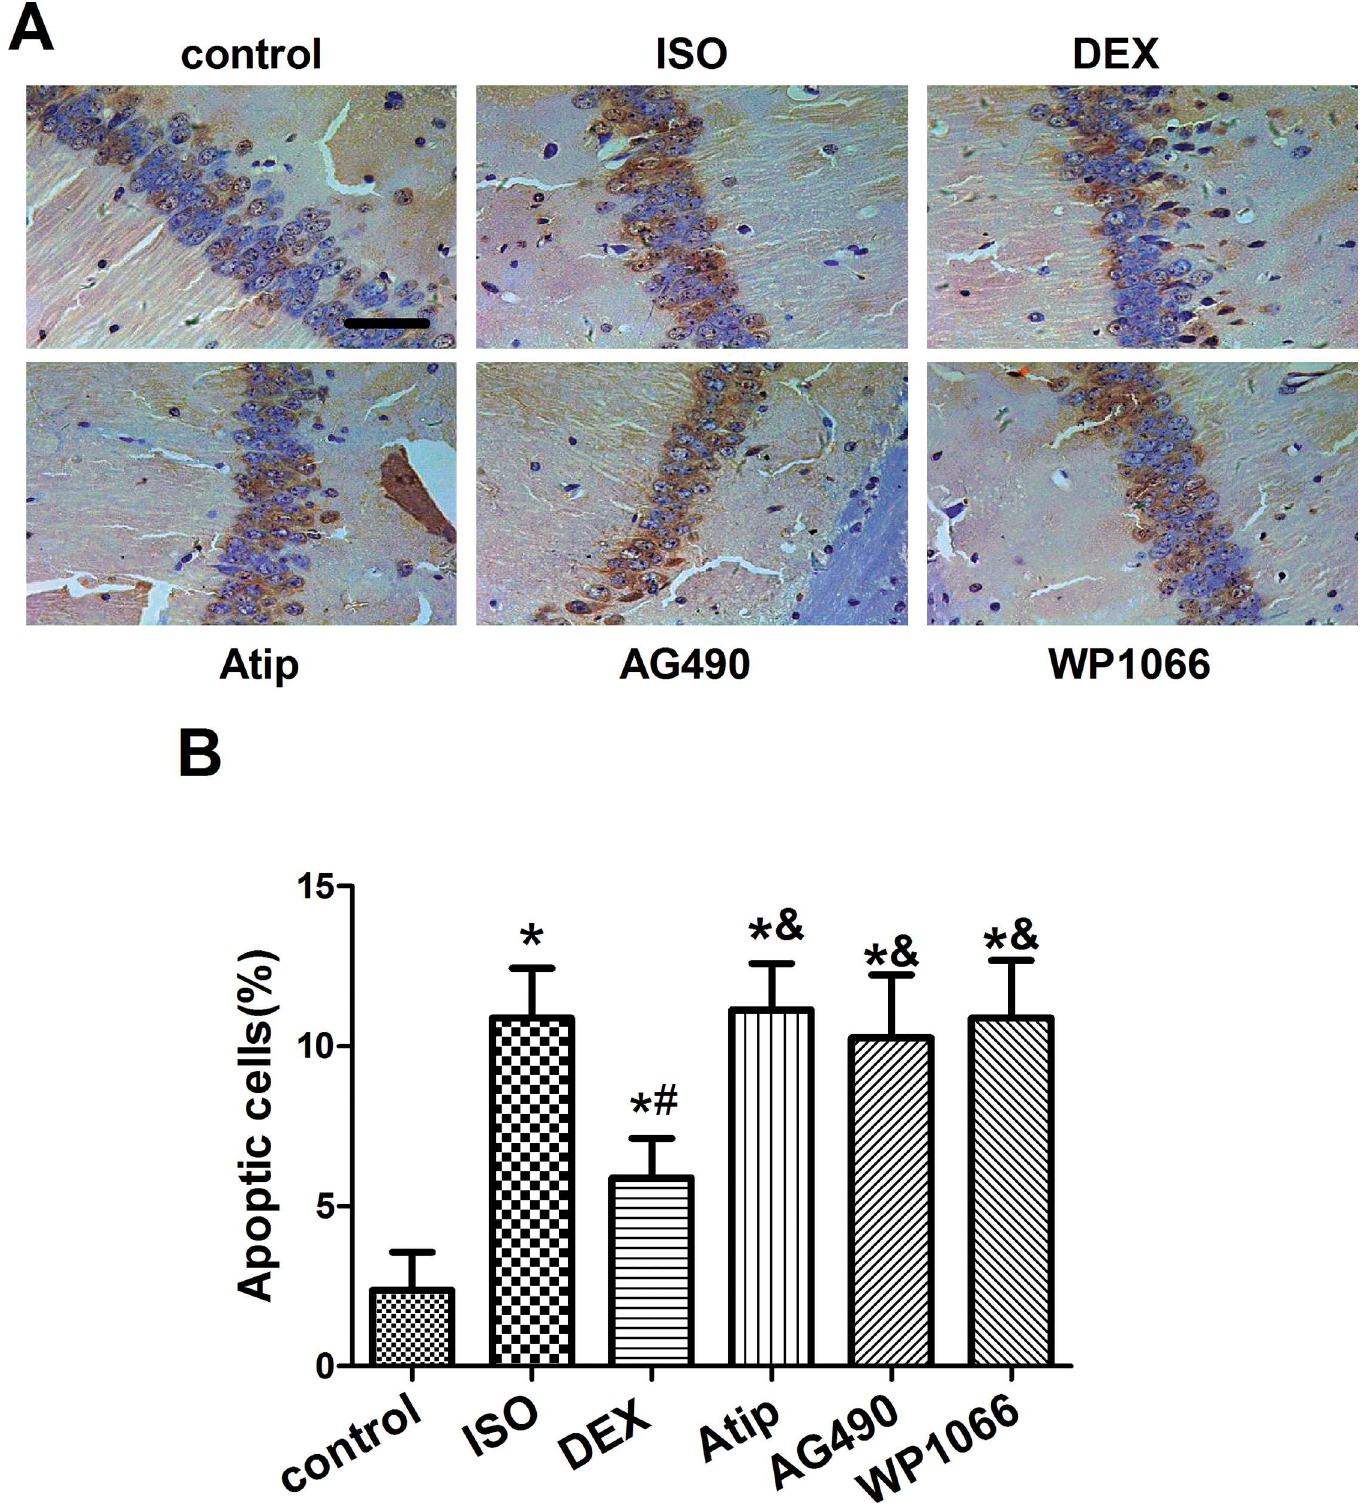
Fig 2. Effects of dexmedetomidine on isoflurane-induced apoptosis in hippocampus. Representative photomicrographs of the hippocampal CA1 region from senile mice at 19 d after treatment with nothing (control) or with isoflurane(ISO) followingpretreatment with nothing or with dexmedetomidine (DEX). Some animals were pretreated with atipamezole (Atip), AG490 or WP1066 prior to DEX. Apoptosis was assessed using terminal